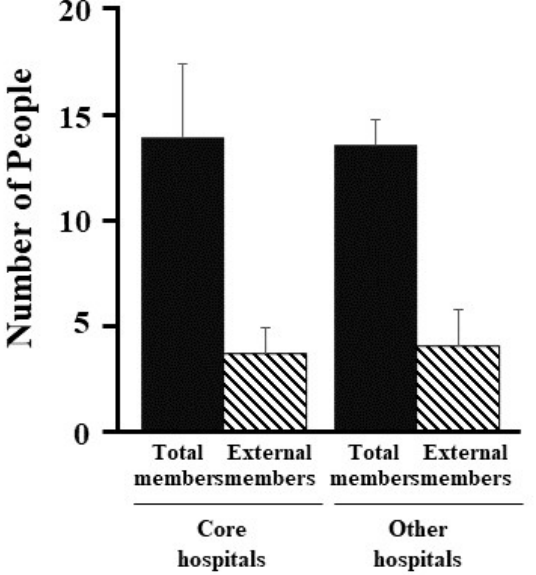
Figure 1. Composition of institutional review board members in Japanese university hospitals.